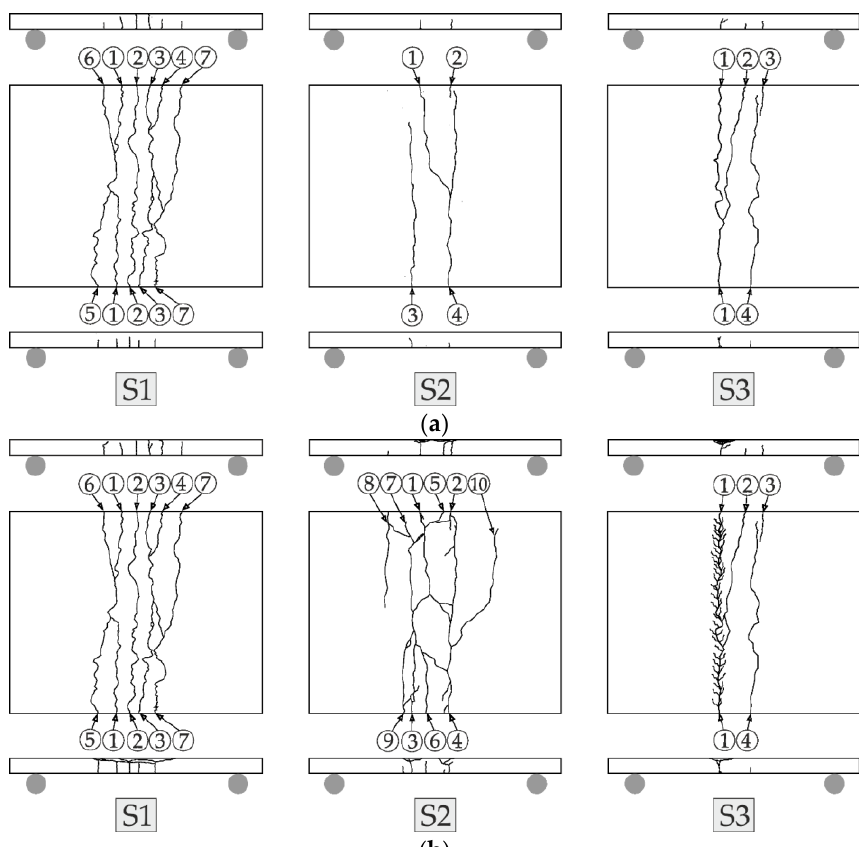
Figure 9. Experimental crack distributions on slab bottom and side surfaces: ( a ) at load of 57 kN; ( b ) at last load.